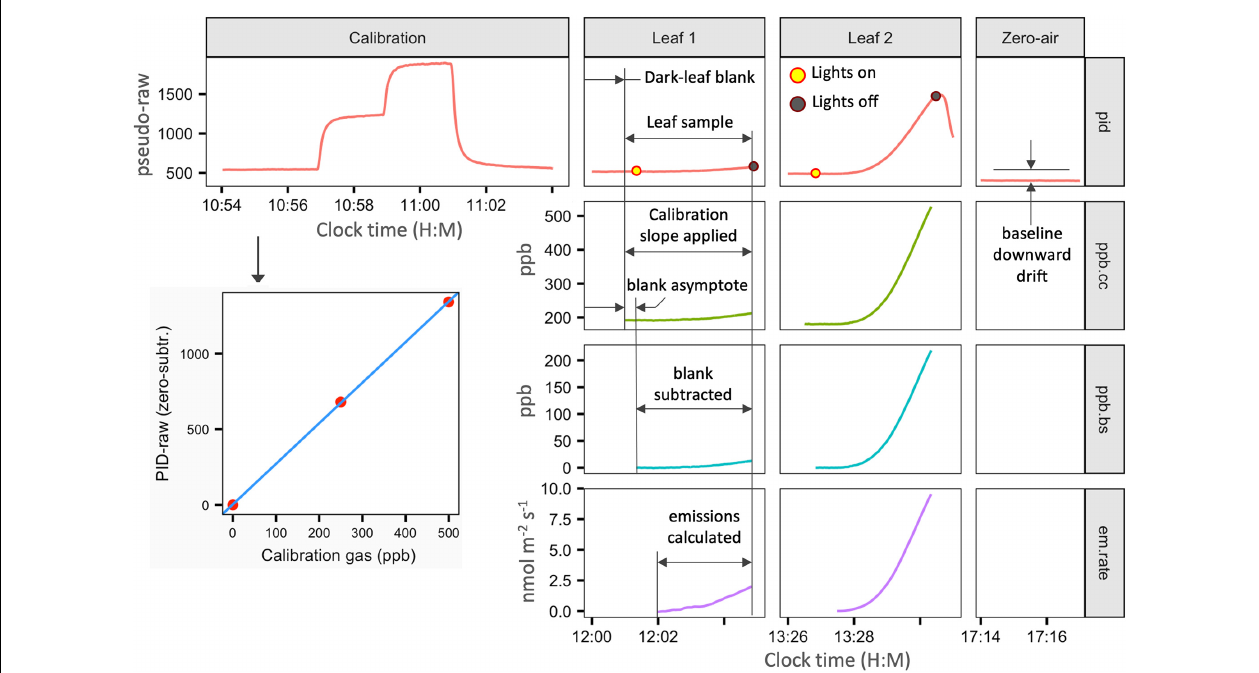
FIGURE 10 | Demonstration of the data processing flow from selected time segments during a day of measurements. Data shown is actual field data from a tropical rainforest. The timing of all calibration and sampling activities are manually noted with 1 s resolution and entered into standardized tables for data processing. Custom processing code in R applies calculations and data transformations according to the activity specified for each time bracket. A calibration determines the responsivity coefficients for conversion of PID pseudo-raw data to gas concentrations. With a leaf in the cuvette, the background is allowed to stabilize for several minutes. Leaf measurement data is converted to calibration-corrected ppb (ppb.cc) by the calibration slope only. The asymptotic tail of the cuvette blank (stabilization period with the leaf in darkness) is then subtracted from the subsequent leaf-sample period (ppb.bs). The relative responsivity to isoprene (0.44 compared to isobutylene calibration gas) is also applied. Emission rate (em.rate) is then calculated as a non-steady-state flux from the time-series of ppb.bs data.